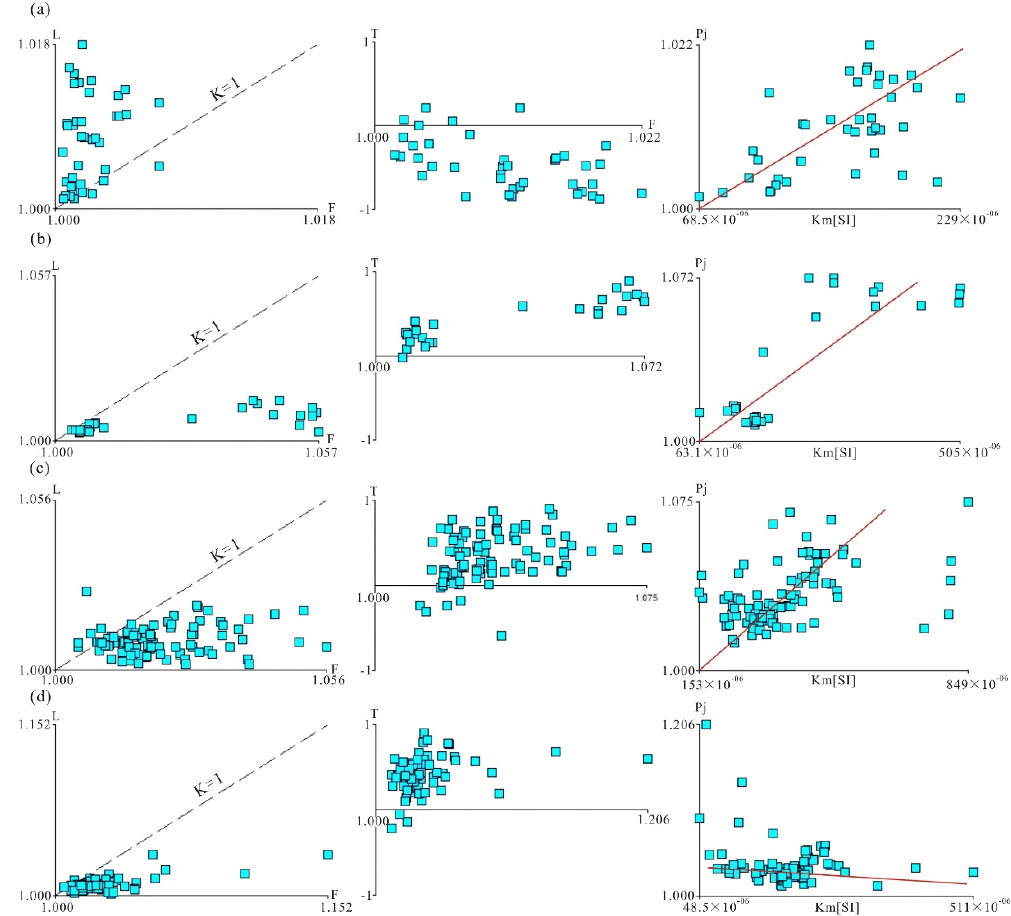
Figure 7. Diagram of magnetic susceptibility parameters for samples from the Jingzhushan Formation in the Late Cretaceous. ( a ) Samples from northwest collection site (KJ 01-08); ( b ) Samples from southwest collection site (KJ24-35); ( c ) Samples from southwest collection site (WKJ01-10); ( d ) Samples from southeast collection site (EKJ01-05). The red line represents a linear correlation.